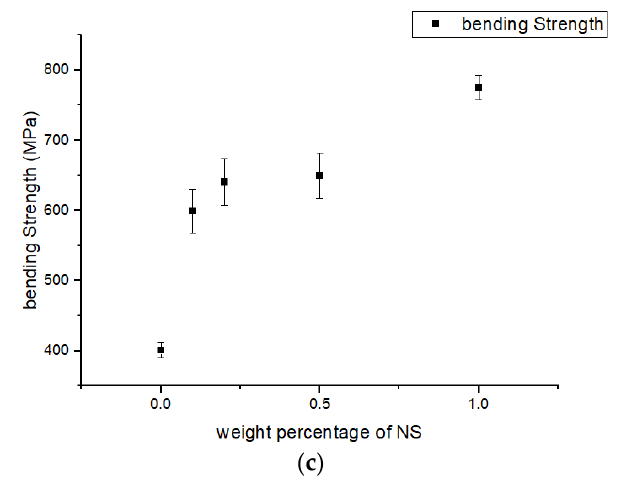
Figure 7. Variation in flexural (bending) strength of modified GFRP samples with different weight percentages of ( a ) MWCNTs, ( b ) NFe, and ( c ) NS.